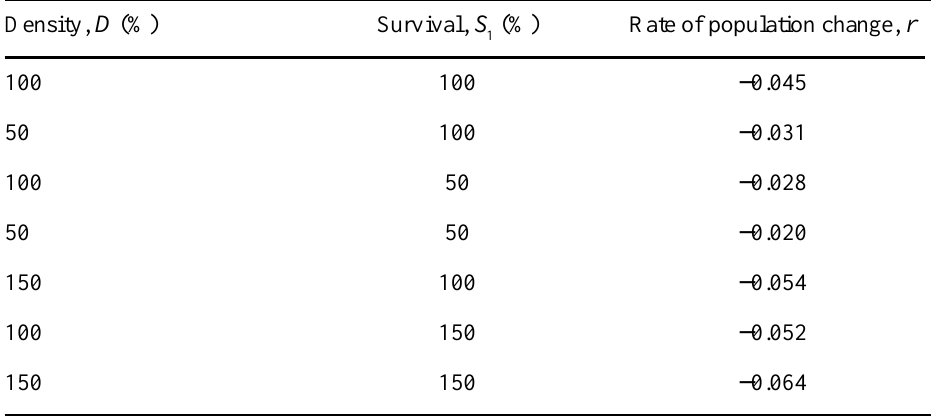
Table 2. Sensitivity of the recruitment model to variation in the density and survival of blue crab early life stages in marsh edge habitat. The first value of r (the rate of population change) was used in simulating a 10% hardened shoreline scenario. Percentages refer to the actual values used in the